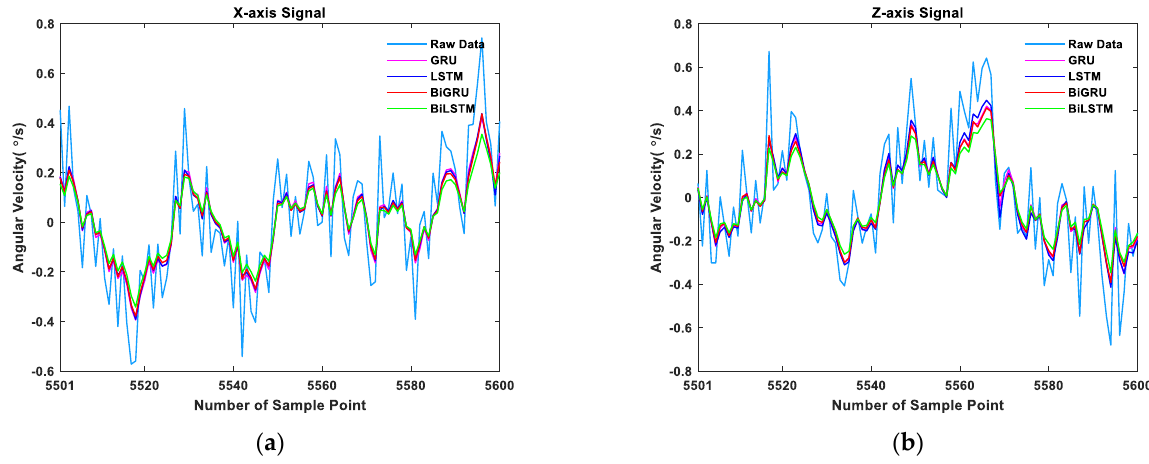
Figure 7. Comparison of error compensation performance of BiLSTM, LSTM, BiGRU, and GRU. ( a ) Part of the x -axis data zoomed-in and ( b ) part of the z -axis data zoomed-in. Table 6. Comparison of raw data, BiLSTM, LSTM, BiGRU, and GRU standard deviation values for x -axis data.